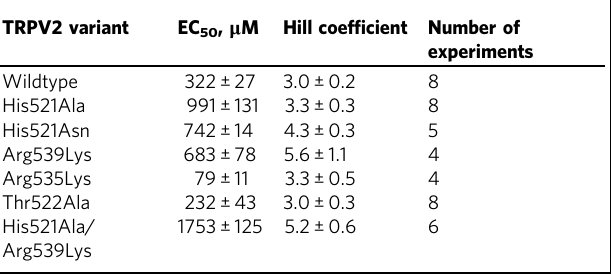
Table 2 Summary of whole-cell patch clamp recordings on HEK293T cells transiently transfected with wildtype or mutant rat